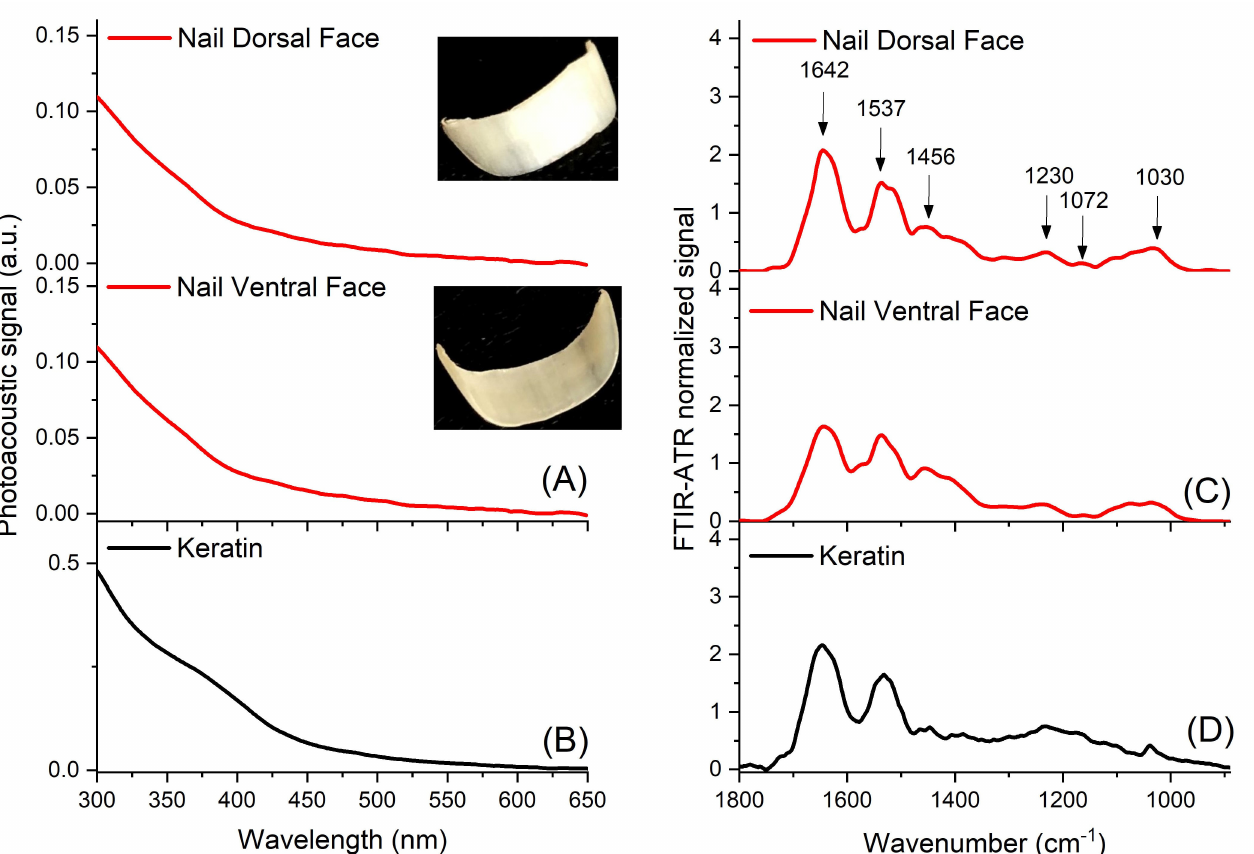
Figure 5. Spectra of human nail without extract (Dorsal Control and Ventral Control) and commercial keratin (Keratin) obtained separately by the PAS technique ( A , B ) and by FTIR-ATR ( C , D ), respectively.